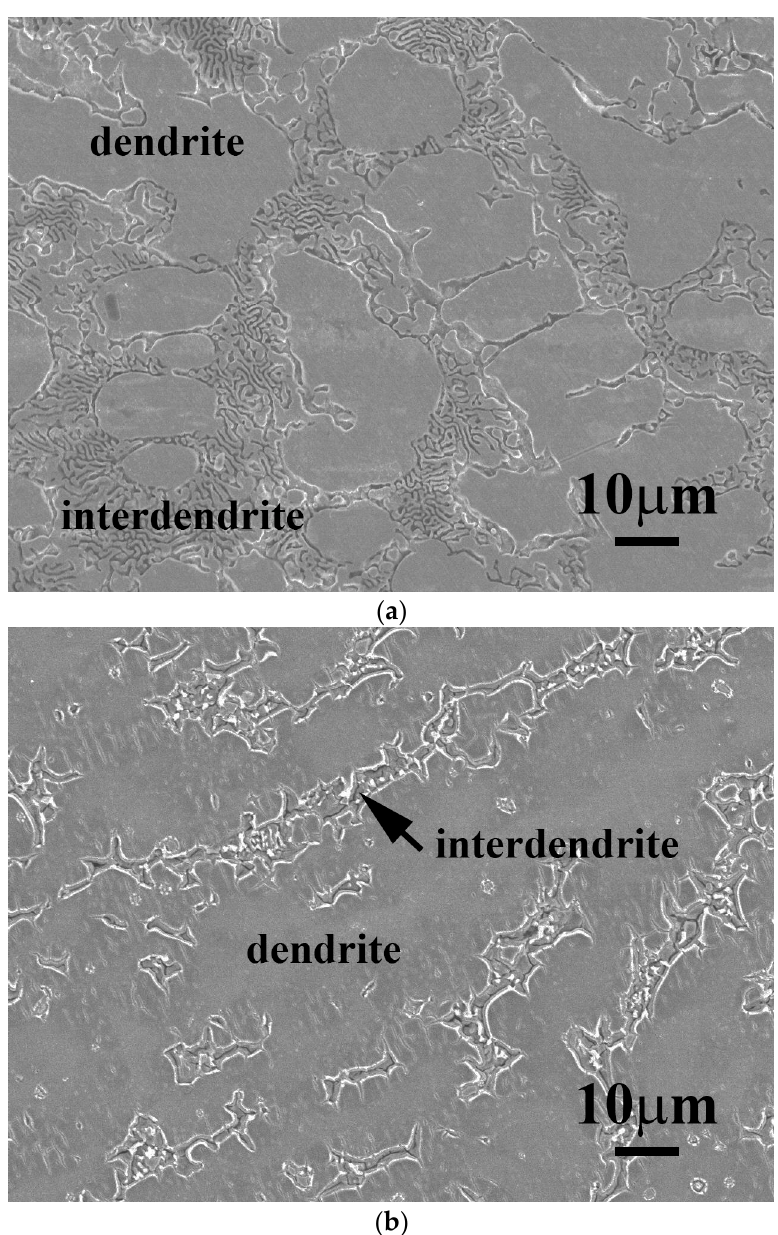
Figure 5. SEM micrographs of the alloys after polarization test in 1 M deaerated H 2 SO 4 solution at 30 °C, ( a ) FeCoNiNb 0.5 Mo 0.5 alloy; and ( b ) FeCoNiNb alloy. Figure 6 plots the polarization curves of FeCoNiNb 0.5 Mo 0.5 , FeCoNiNb, FeCoNi and 304SS alloys in 1 M deaerated NaCl solution. Table 5 presents the corrosion potentials and corrosion current densities that are obtained from the curves. The corrosion potentials of FeCoNiNb 0.5 Mo 0.5 and FeCoNiNb alloys were close to the E corr of FeCoNi alloy, these alloys were all nobler than 304 stainless steel. This result indicates that adding Nb/Mo to FeCoNi alloy did not significantly change its E corr , although but did change its microstructures to dual-phased ones. However, the dual-phased microstructures of FeCoNiNb 0.5 Mo 0.5 and FeCoNiNb alloys significantly influenced on the i corr of the alloys. The corrosion current densities of FeCoNiNb 0.5 Mo 0.5 and FeCoNiNb alloys exceeded the i corr of FeCoNi alloy; but smaller than the i corr of 304 stainless steel. FeCoNiNb 0.5 Mo 0.5 alloy had a large